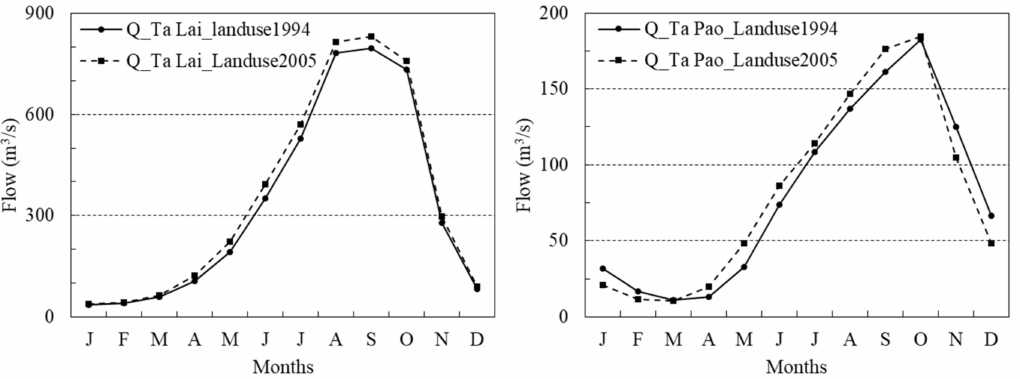
Figure 6. Comparison of monthly streamflow (Q–m 3 /s) between Landuse 1994 and 2005 at Ta Lai and Ta Pao